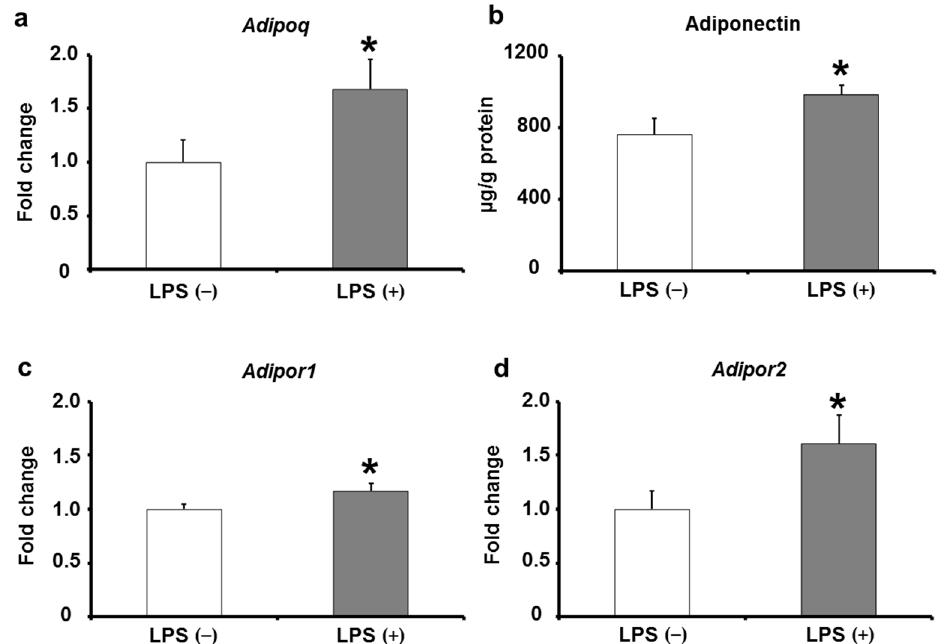
Figure 6. Effects of orally administered LPS on adiponectin expression in the adipose tissues of KK/Ay mice. ( a ) The relative mRNA expression of adiponectin was measured ( n = 8). ( b ) The relative protein level of adiponectin was measured by enzyme-linked immunosorbent assay ( n = 8). ( c , d ) Relative mRNA expression levels of Adipor1 and Adipor2 were measured by quantitative reverse- transcription polymerase chain reaction ( n = 8). Values are presented as the mean ± SE. * p < 0.05 vs. LPS ( − )